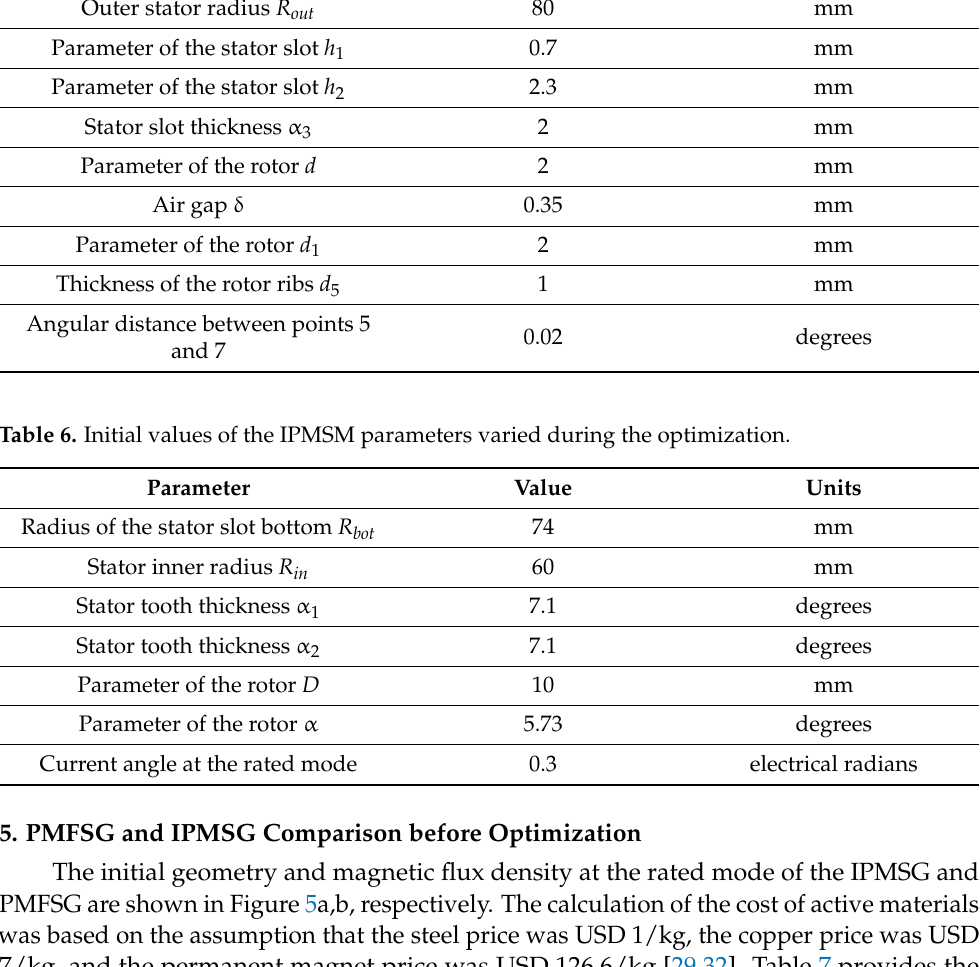
Figure 4. IPMSG parameters: ( a ) Stator parameters; ( b ) Rotor parameters. Table 5. Fixed parameters of the interior permanent magnet synchronous machine (IPMSM). Parameter